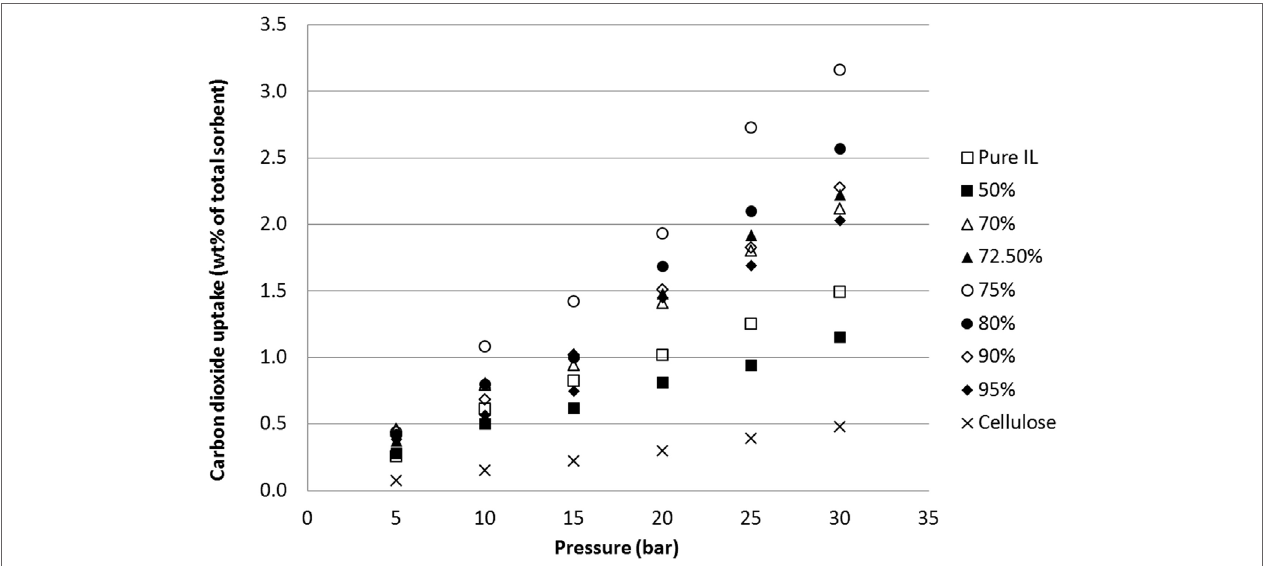
FigUre 4 | Uptake capacities of CO 2 at various pressures on [N 4444 ][Ac] across a range of cellulose loadings at room temperature.